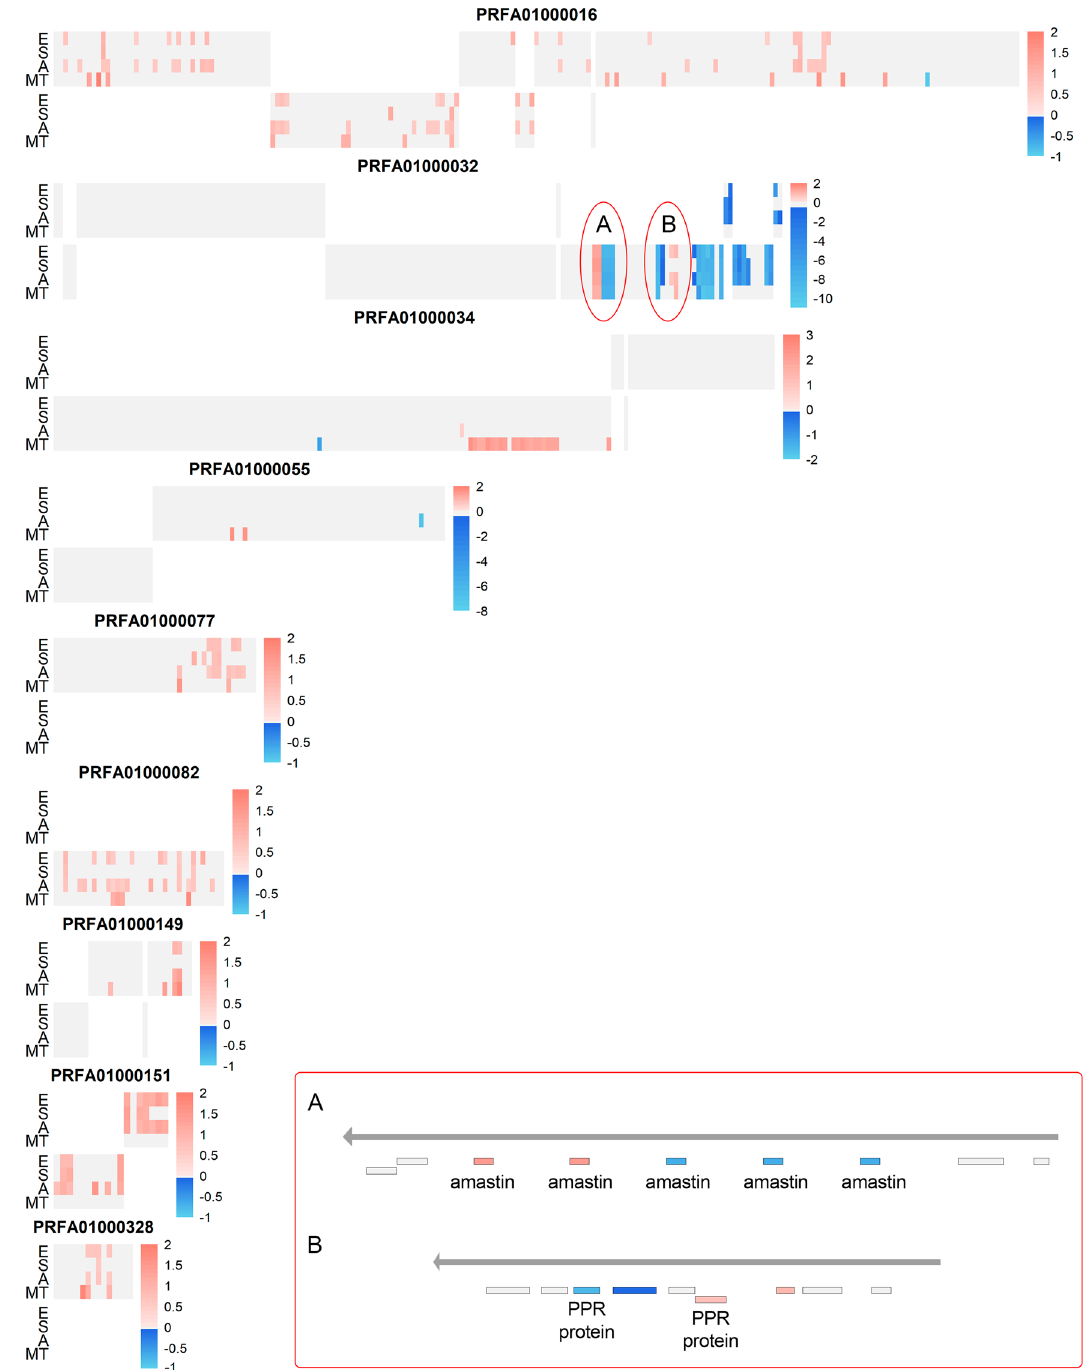
Figure 6. Clusters of differentially expressed genes. Each heatmap shows a chromosome whose ID name is at the top, and it is grouped in 2 panels with the upper panel representing genes encoded in the plus strand and the bottom panel genes encoded in the minus strand. Each column shows a gene, and each line shows a developmental stage comparison (KO/WT), identified by the letters: E, epimastigotes; S, stressed epimastigotes; A, 24 h adhered differentiating forms; MT, metacyclic trypomastigotes. Differentially expressed genes are represented by red and blue colors (z-score scale at left), which indicates up and down regulation (KO/WT), respectively. Genes that were not differentially expressed are represented in grey and absence of genes is represented in white. ( A ) Gene cluster detail including amastin genes. ( B ) Gene cluster details including PPR protein